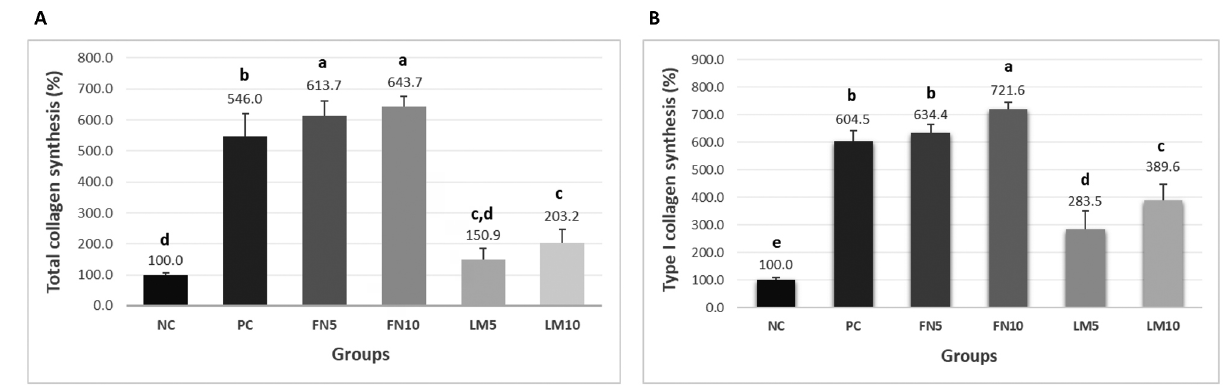
Figure 5- Mean and standard deviation of total collagen (A) and type I collagen (B) synthesis values (n=6; one-way ANOVA/Tukey tests; α =0.05). Different letters demonstrate a significant difference between groups